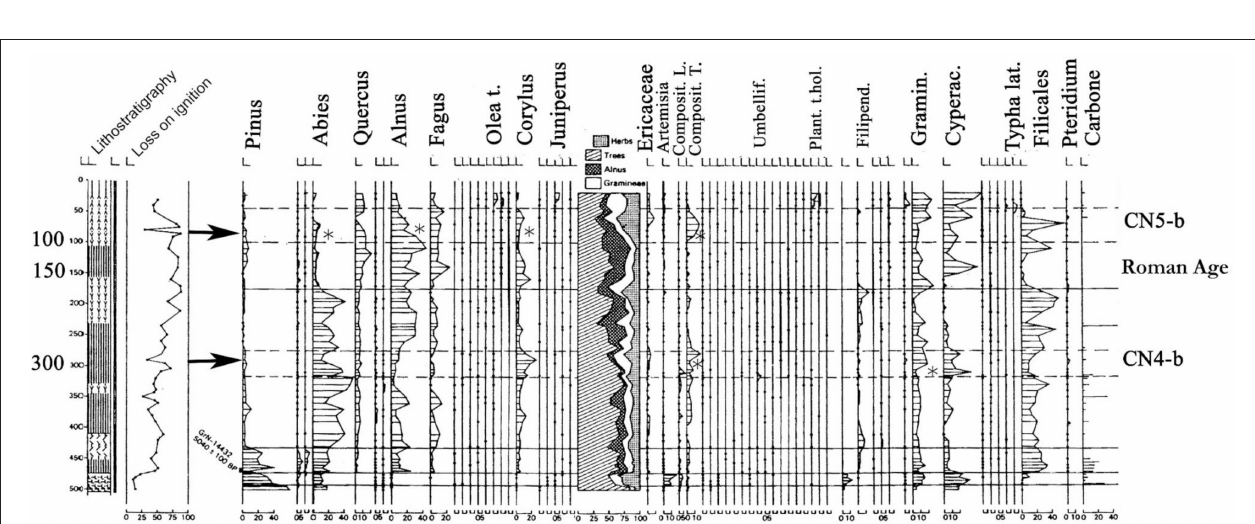
FIGURE 3 | Comparison of pollen percentages and macrocharcoal (not identifiable) concentration (mean values) during the phase characterised by the alnocoltura practice (AP) and the unmanaged phase (UP) at the four selected sites (A–D) in Molinari and Montanari (2016, p. 39).